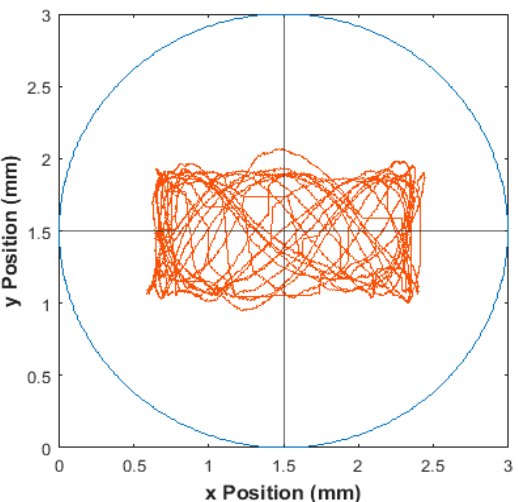
Figure 18. Orbit plot of rotor when spun at 500 rpm, circle represents the allowable limit of move- ment for the rotor.